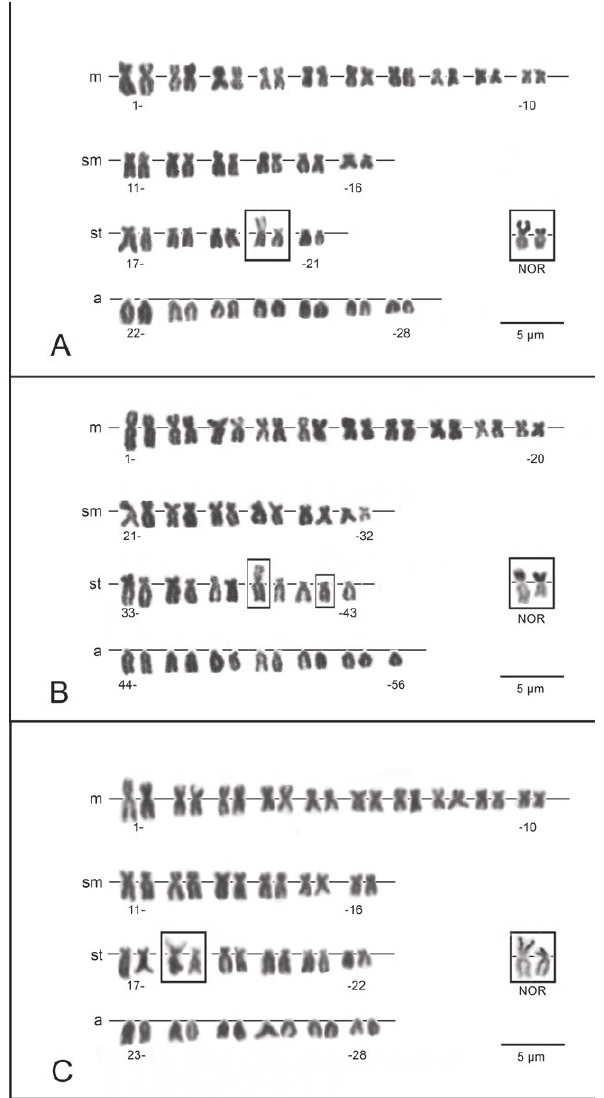
Figure 1. Karyotype of Leiarius marmoratus (A), the hybrid “cachandiá” (B) and Pseudoplatystoma reticulatum (C) after Giemsa staining. In the box, the NOR-bearing chromosomes.